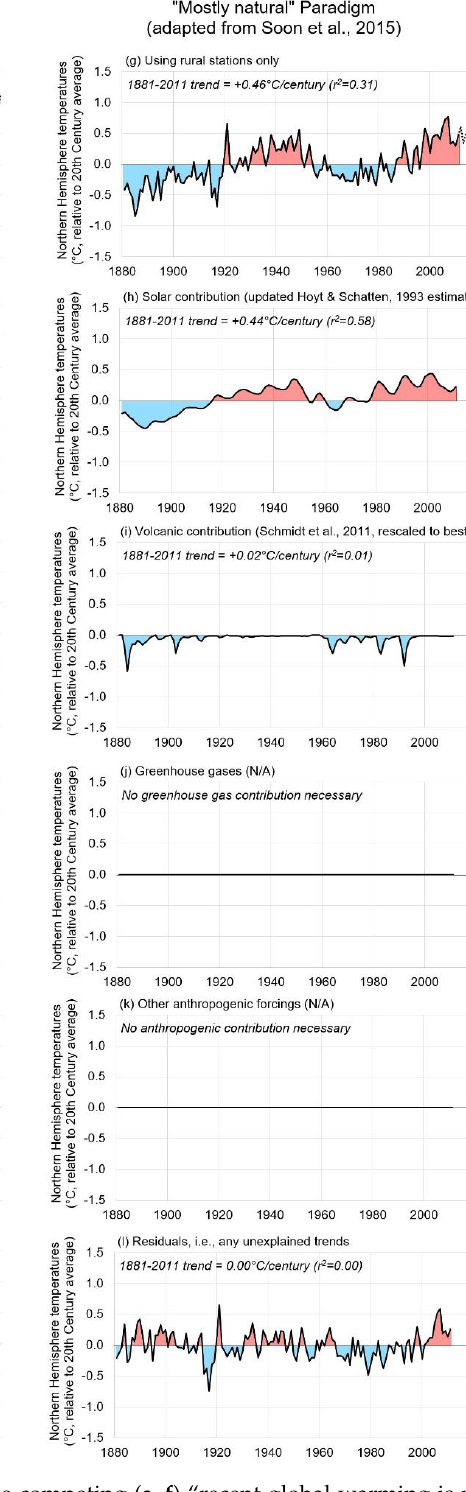
Figure 11. Example of two narratives from the competing ( a )–( f ) "recent global warming is mostly human-caused" and ( g )–( l ) "recent global warming is mostly natural" paradigms. See text for a detailed discussion. The horizontal axes correspond to years.